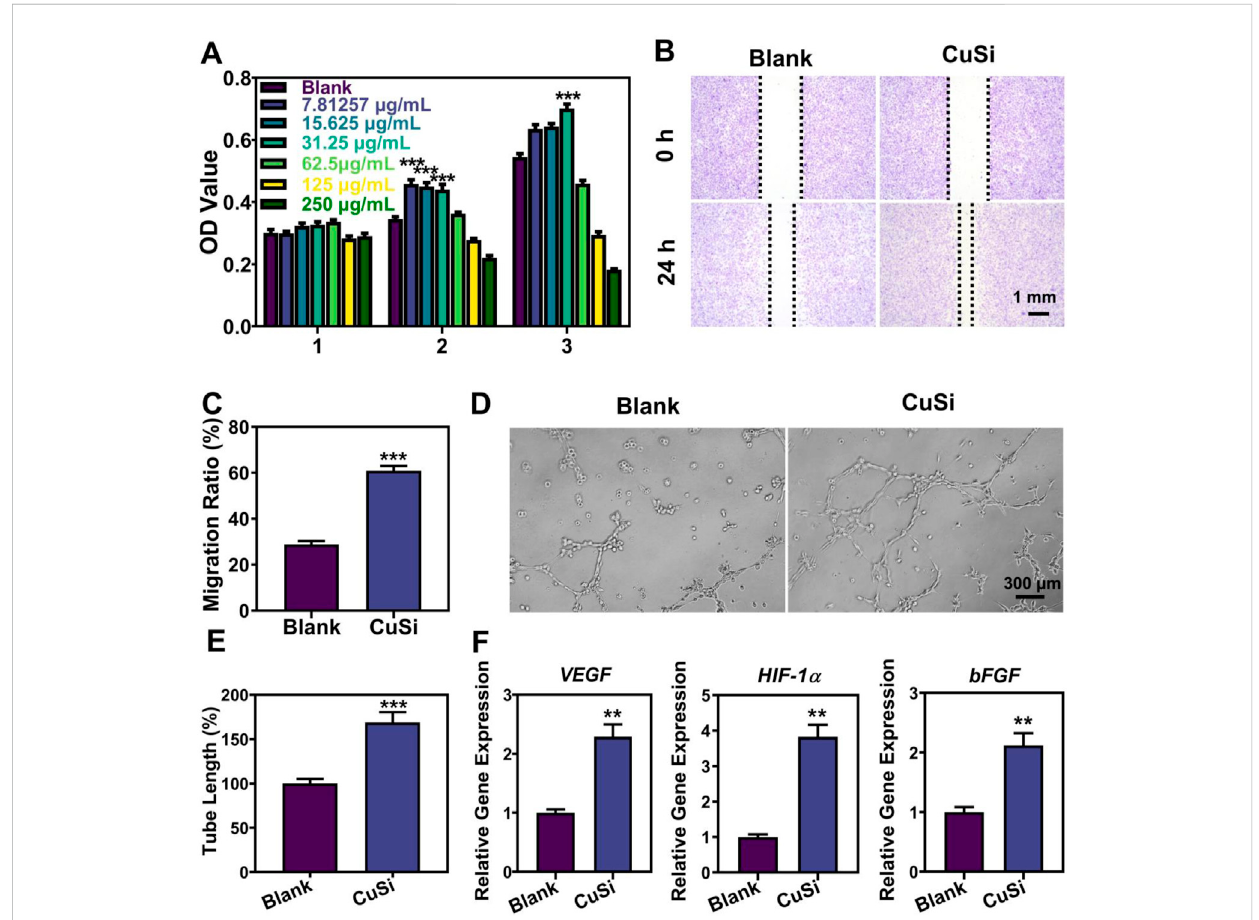
FIGURE 4 Effects of CuSi NWs on the proliferation, migration, and pro-angiogenesis of HUVECs. (A) Cell viability of HUVEC after treatment with different CuSi NWsconcentrations( n = 6). (B) Representative cell migration photos after treatment with/withoutCuSiNWsfor 24 h. (C) Quanti fi cationof cellmigration rate ( n = 8). (D) Representative newly formed tubes after treatment with/without CuSi NWs for 6 h. (E) Quanti fi cation of tube length ( n = 7). The Blank group was normalized. (F) Angiogenic genes ( VEGF , HIF-1 α and bFGF ) expression in HUVECs after treatment with CuSi for 3 days ( n = 3). * p < 0.1, ** p < 0.01 or *** p <